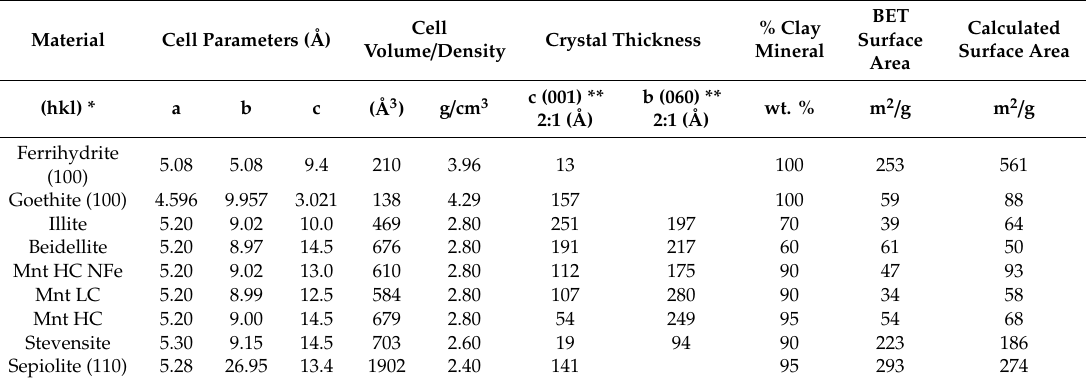
Table 1. Crystallographic and physical properties of the adsorbents used in this study. Material Cell Parameters (Å)